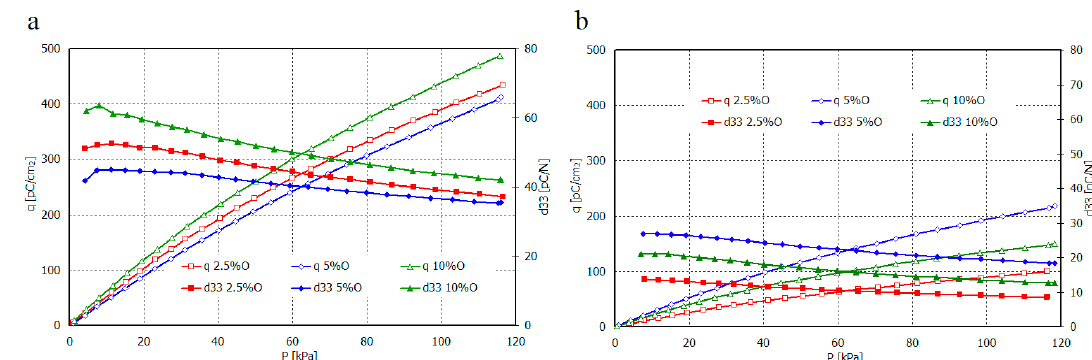
Figure 9. Dependence of piezoelectric charge and piezoelectric coefficient d 33 vs mechanical stress for oriented (O) films HDPE + Sillikolloid P87 ( a ) and MDPE + Sillikolloid P87 ( b ).